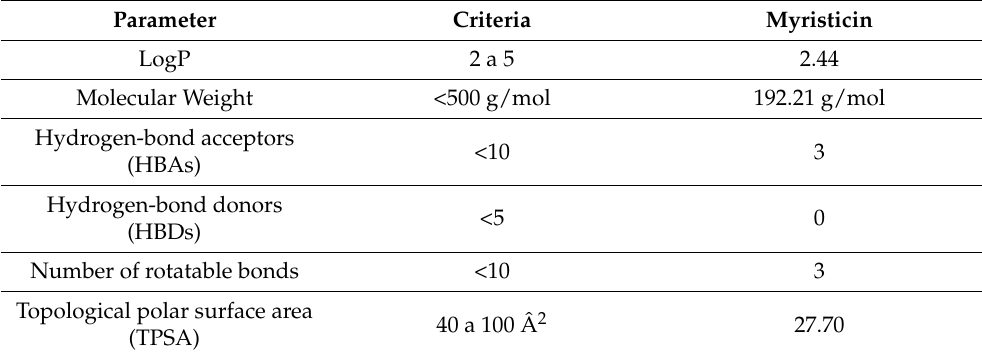
Table 3. Predicted pharmacokinetic parameters for myristicin compared to Lipinski’s criteria. Parameter